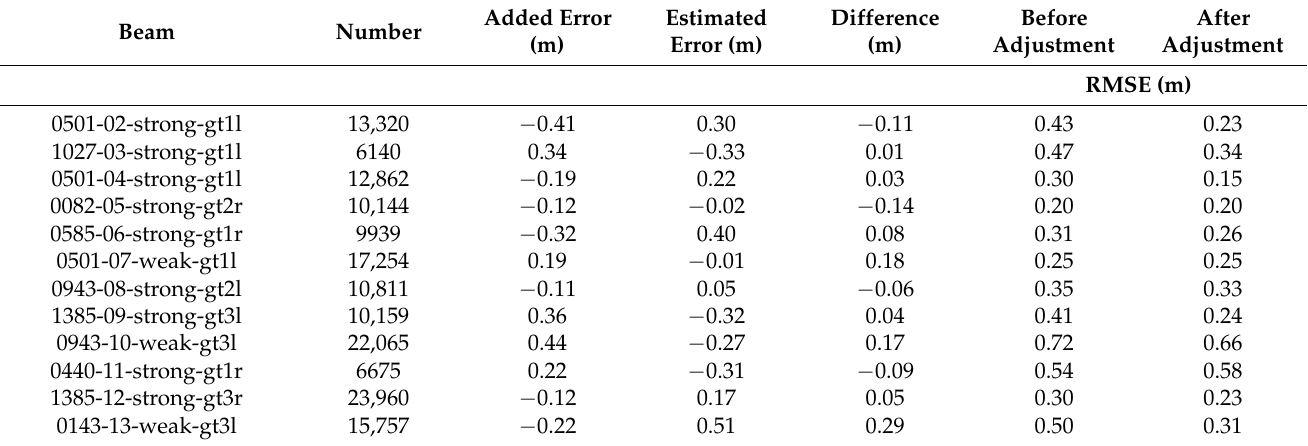
Table 4. Comparison of data accuracy for simulation validation of crossover